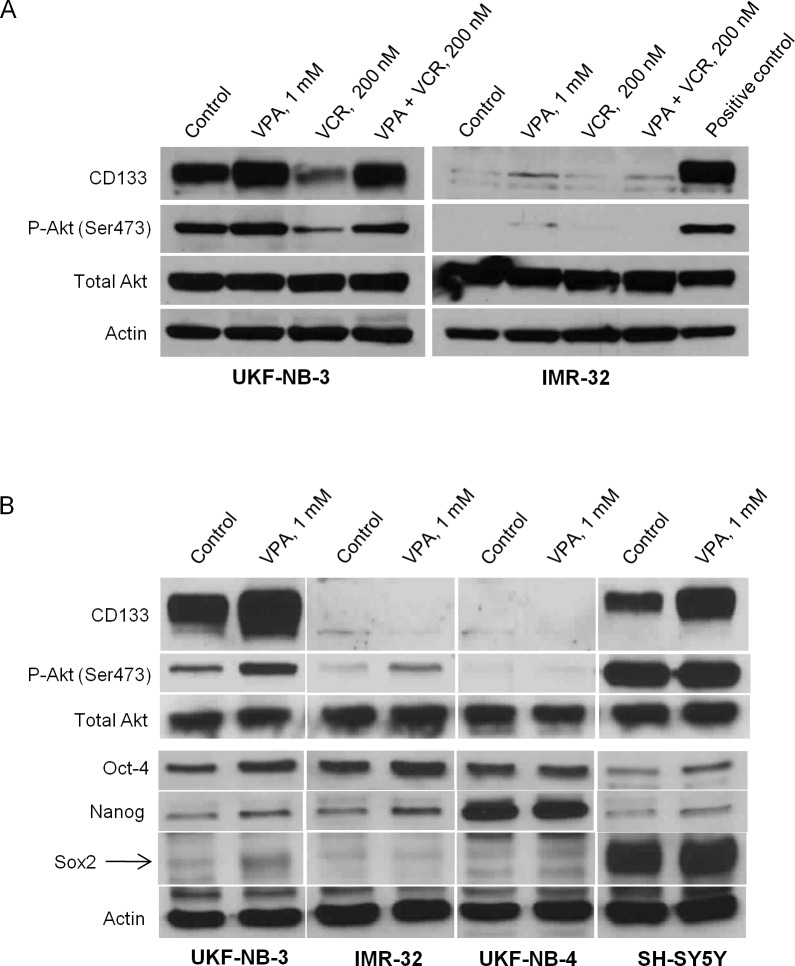
Expression of CD133, P-Akt, Oct-4, Nanog and Sox2 in NB cell lines after treatment with 1mM VPA.(A) Changes of P-Akt in UKF-NB-3 were correlated to the changes of CD133 under all examined conditions (1mM VPA or 200nM VCR for 24 hrs). Positive control- UKF-NB-3 cells treated with 1mM VPA for 24 hrs. (B) 72 hrs cultivation with VPA induced CD133 overexpression only in UKF-NB-3 and SH-SY5Y cell lines. P-Akt was highly expressed in CD133-expressing cell lines. Phophorylation of Akt increased with VPA treatment in UKF-NB-3, whereas its expression was extremely high in SH-SY5Y whether in the control or VPA treated sample. Oct-4 was mainly expressed in MYCN amplified cell lines (UKF-NB-3, IMR-32 and UKF-NB-4) and was enhanced after treatment with VPA in UKF-NB-3, IMR-32 and SH-SY5Y. Nanog expression was detected in low amount that enhanced by VPA in UKF-NB-3, IMR-32 and SH-SY5Y, while it was highly expressed in UKF-NB-4. SOX2 was slightly expressed in UKF-NB-3 and was induced by VPA while it was over expressed in SH-SY5Y independent of VPA effect.